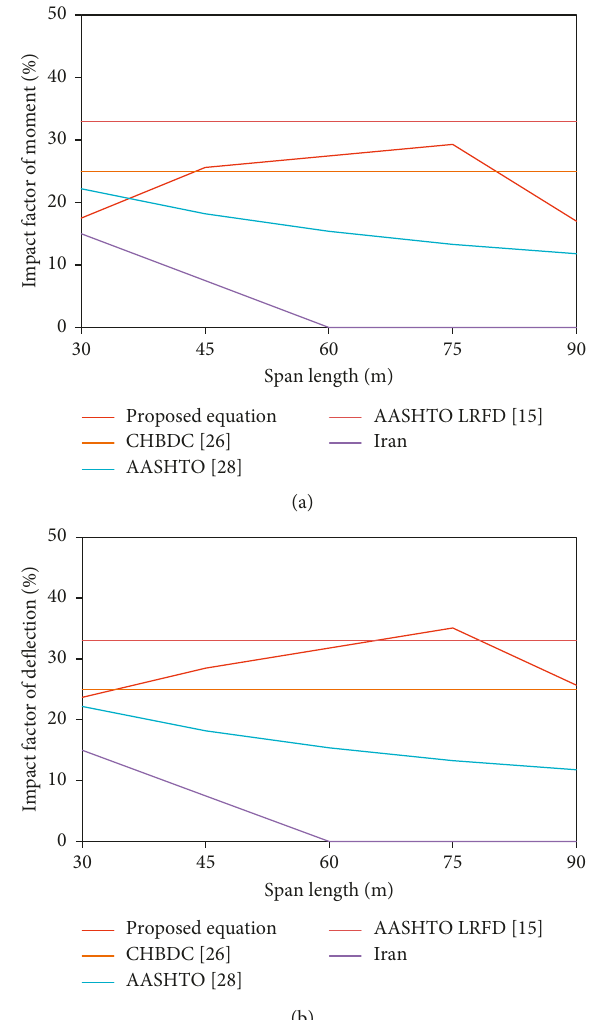
Figure 13: Comparison of proposed expressions with various codes. (a) Dynamic impact factor for bending moment; (b) dy- namic impact factor for